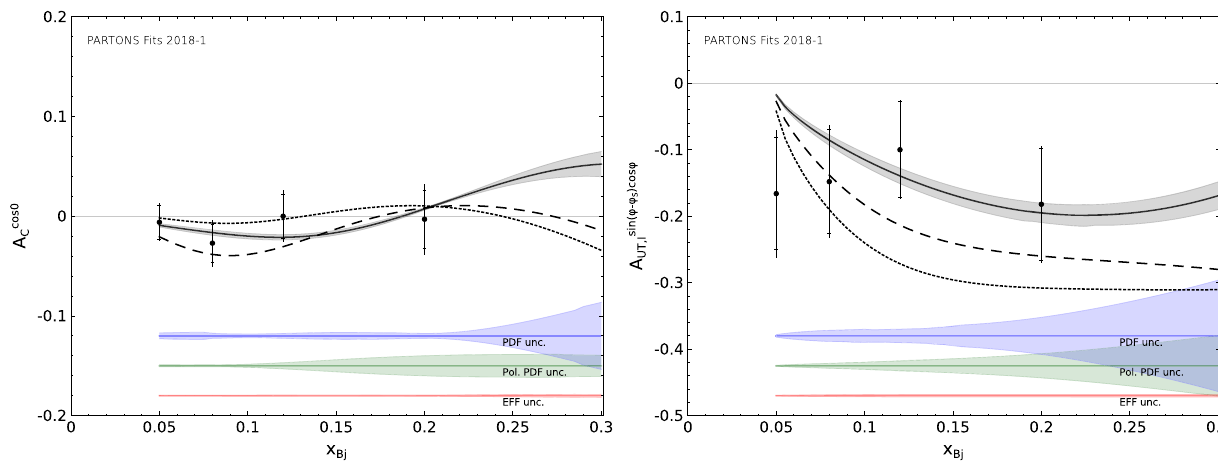
Fig. 8 Comparison between the results of this analysis, some selected GPD models and experimental data published by HERMES in Ref. [120] φ (φ − φ S ) cos φ for A cos0 (left) and A sin (right) at t = − 0 . 12 GeV 2 and Q 2 = 2 . 5 GeV 2 . For further description see Fig. 6 C UT , I